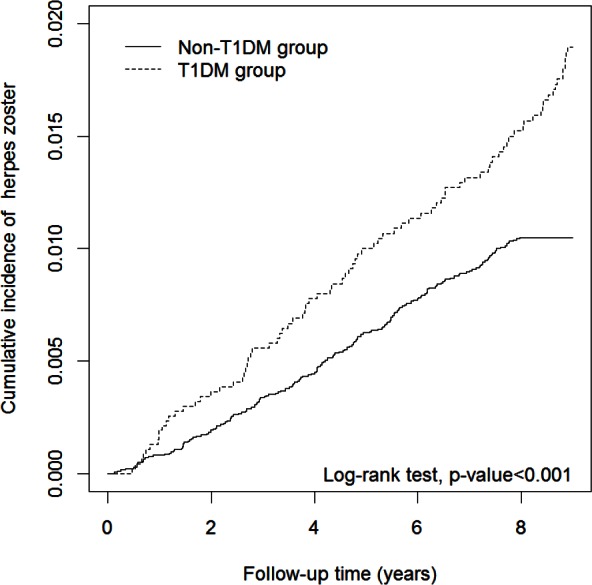
Cumulative incidence curves of herpes zoster for groups with and without T1DM.T1DM, type 1 diabetes mellitus.